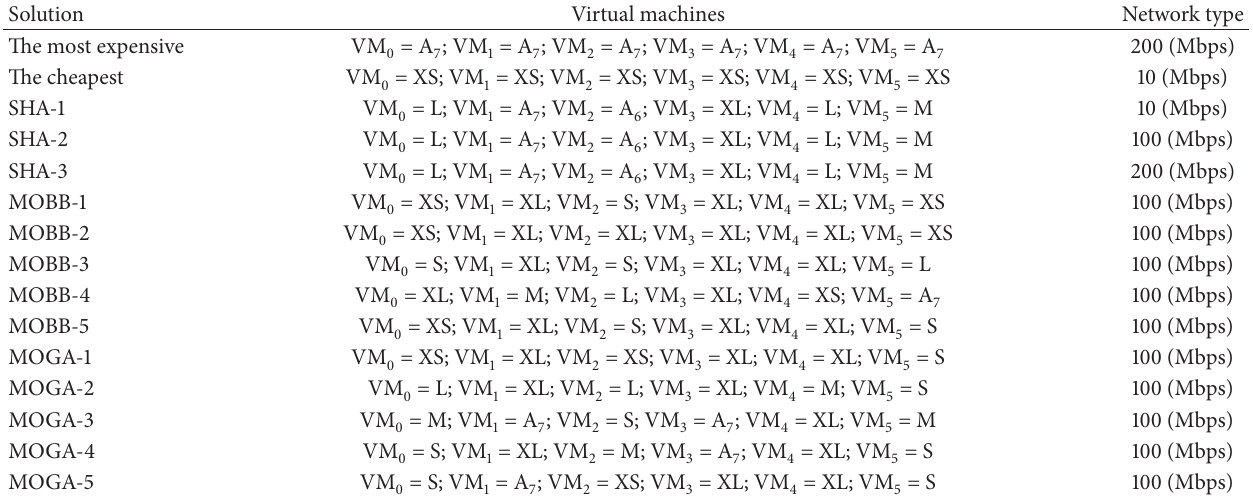
Table 11: Proposed paretooptimal VM and network configurations for workload